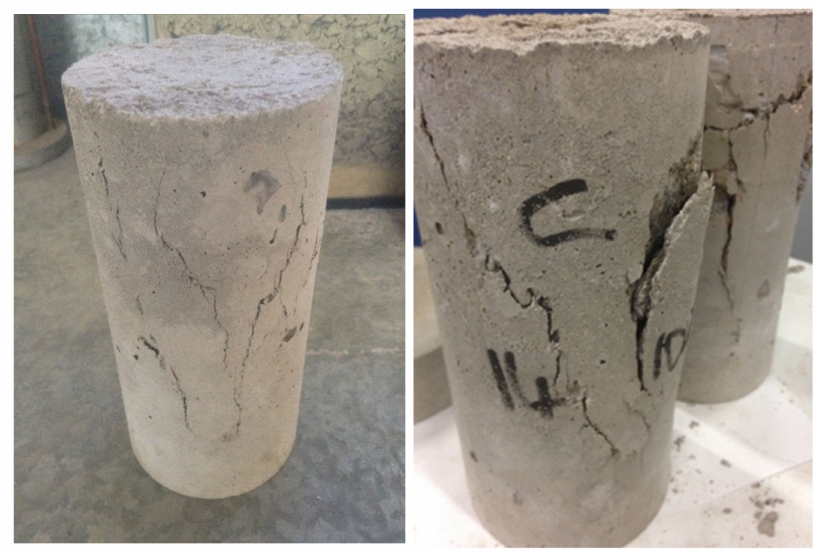
Figure 13. The typical fracture of the cylindrical concrete